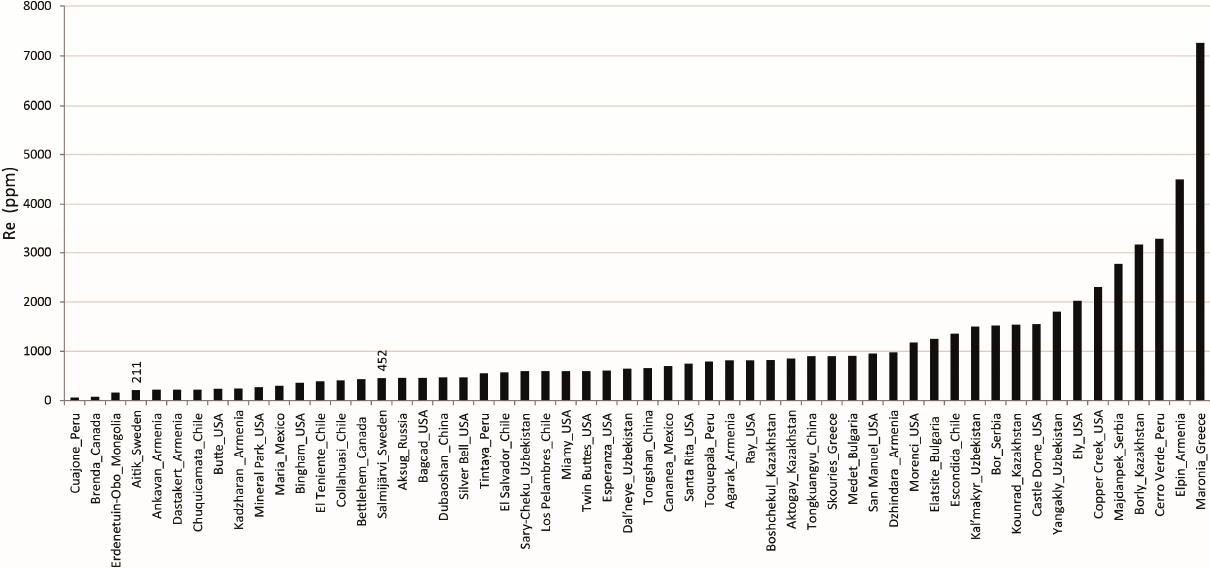
Figure 8. Rhenium grades in porphyry Cu and Cu-Mo systems worldwide. Modified from